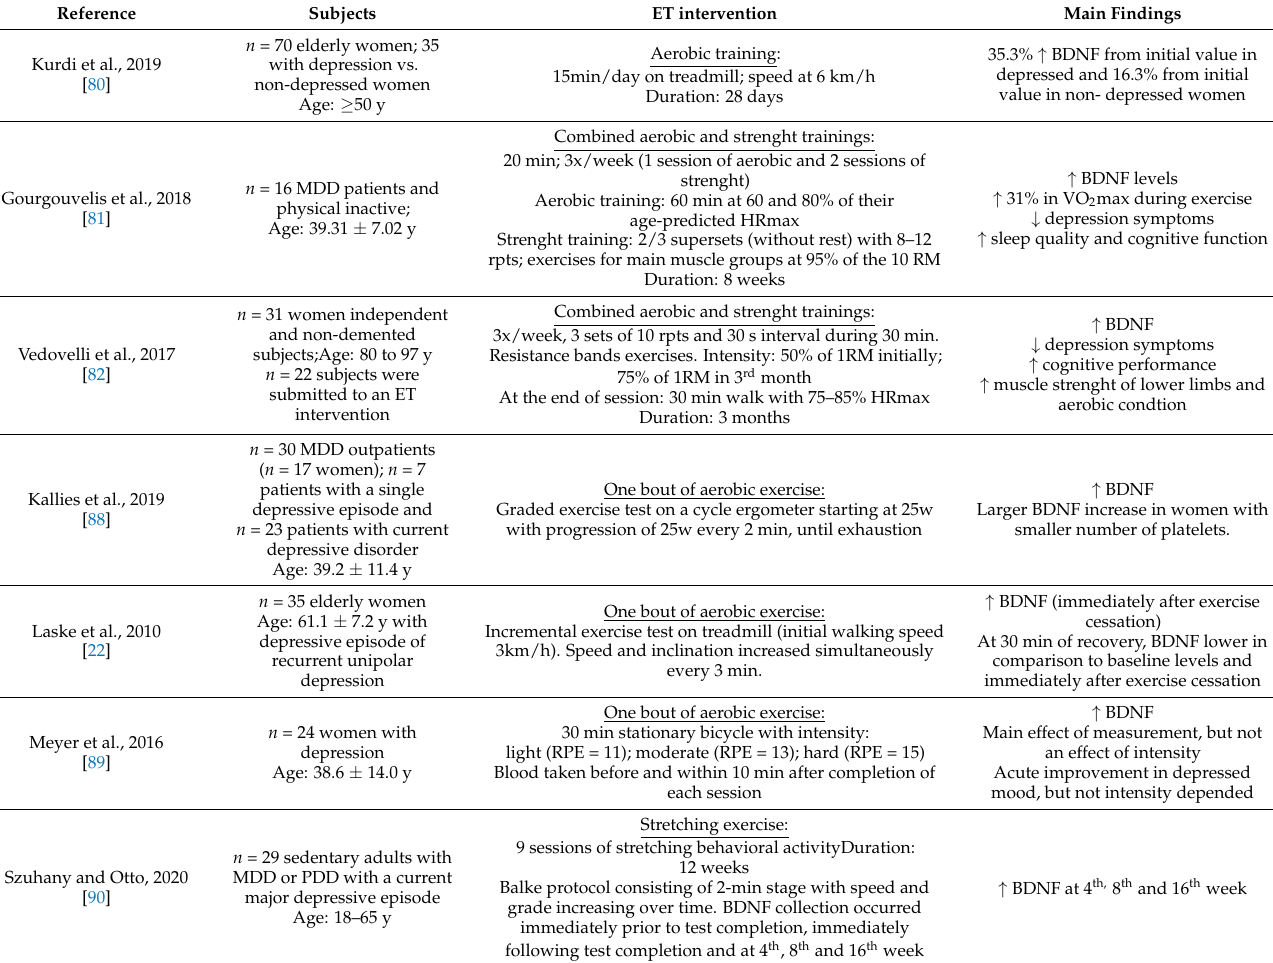
Table 1. Effects of exercise training on BDNF levels in depressed